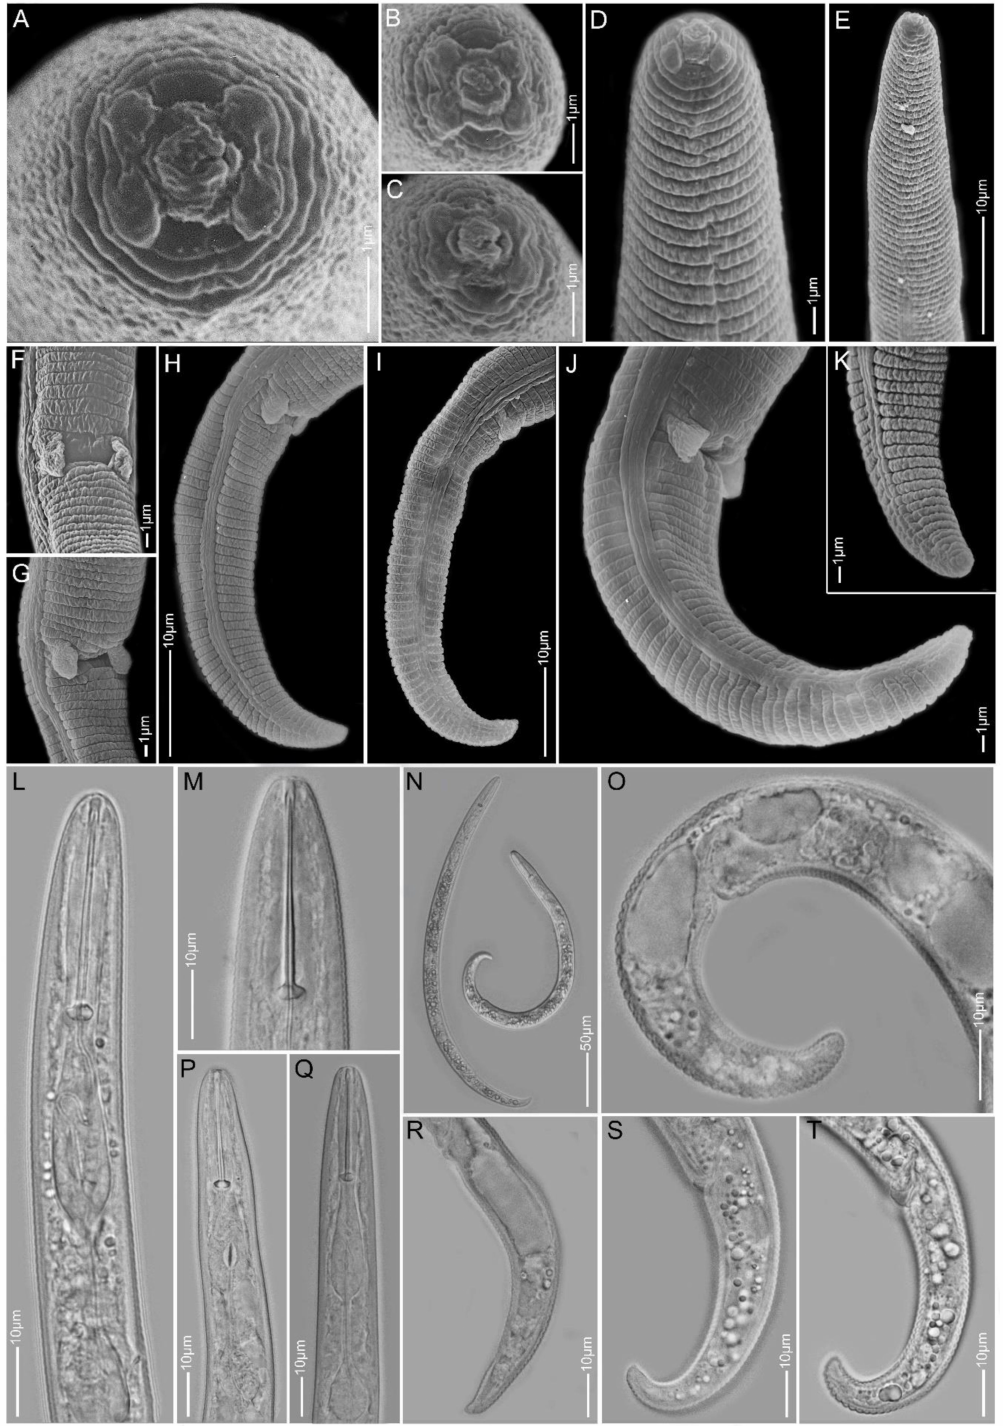
Figure 15. Light and scanning electron microscopy images of Paratylenchus sp.F females: ( A – C ) face view; ( D , E , L , M , P , Q ) anterior region; ( F , G ) vulva region; ( H – K , O , R – T ) tail region; ( N ) total